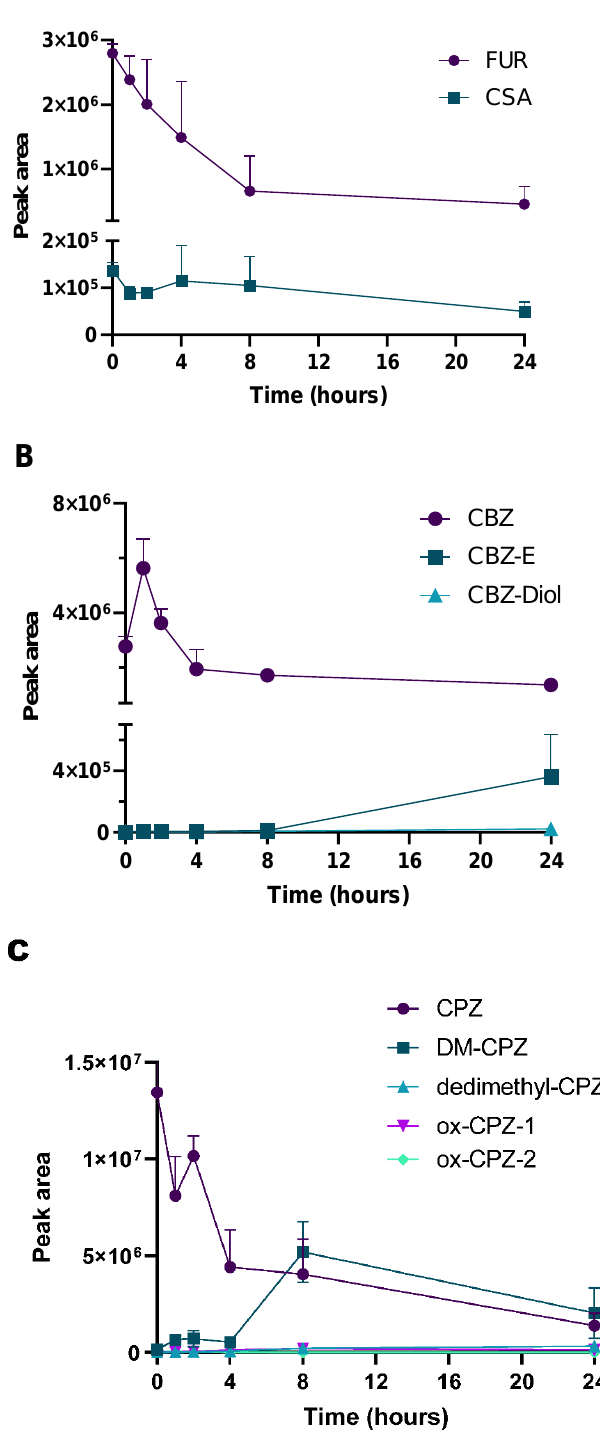
Figure 4. Pharmacokinetic plots of furosemide (FUR) panel ( A ), carbamazepine (CBZ) panel ( B ) and chlorpromazine (CPZ) panel ( C ). The analysis of drugs and the corresponding metabolites was performed at different time points (0, 1, 2, 4, 8 and 24 h post-treatment).